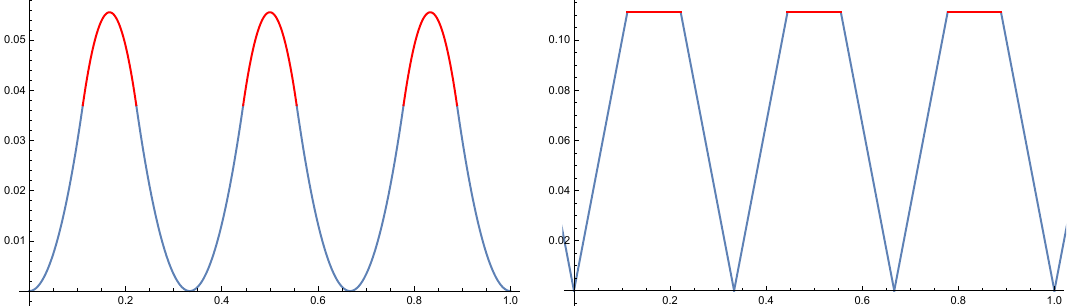
Figure 7 . The portions of parabolas and cusps in the dominant and subdominant regions for m = 3 . The figure to the left shows a plot of V ( ν ) as a function of ν . The figure to the right shows a plot 2 of V ( ν ) as a function of ν . In both plots ν ranges from zero to one. The blue portions correspond 1 to the dominant regions. The red portions correspond to the subdominant